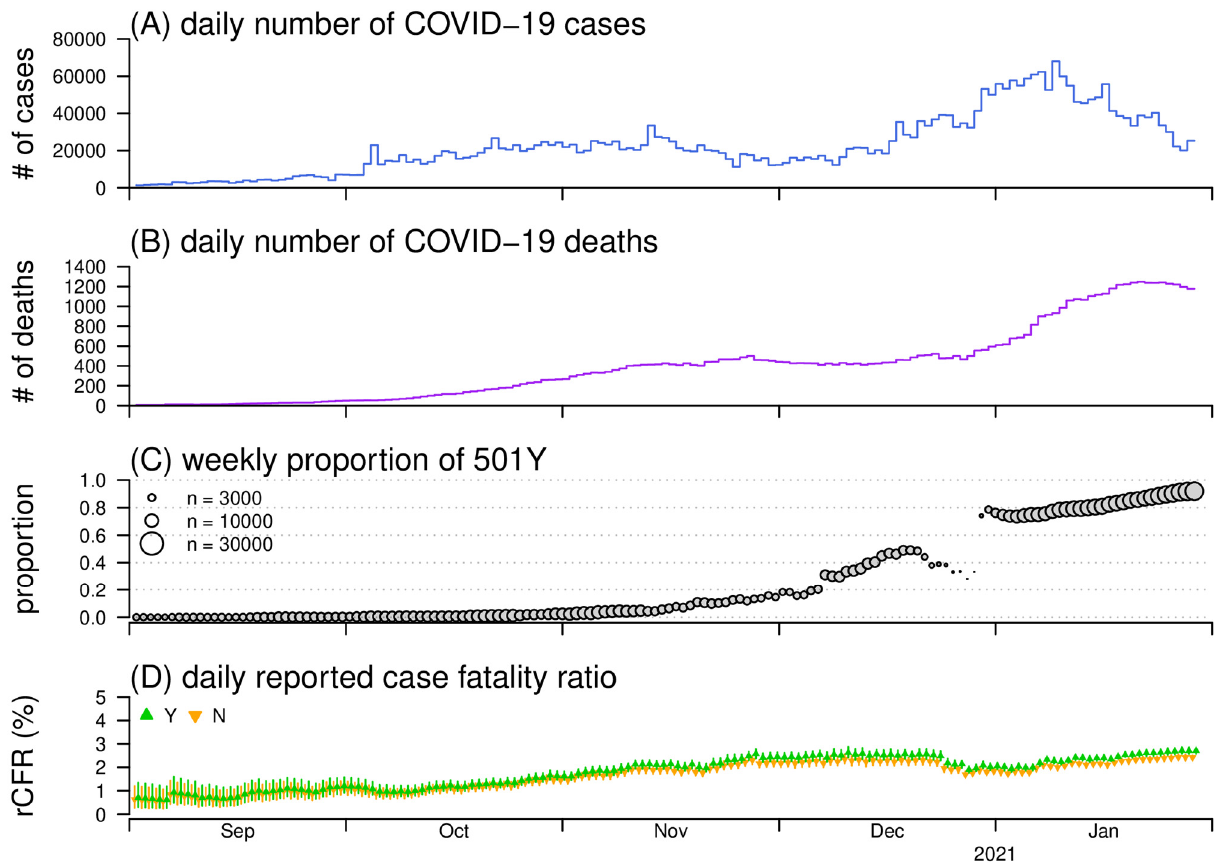
Figure 1. The daily number of COVID-19 cases ( A ) and deaths ( B ), proportion of the 501Y SARS-CoV-2 variants ( C ), and the reconstructed reported case fatality ratios (rCFR) ( D ). Panel ( A ) and ( B ) show the daily number of COVID-19 cases and deaths time series in the UK, respectively. Panel ( C ) shows the observed proportion of 501Y variants among all samples of SARS-CoV-2 strains, where the size of the dot indicates the weekly sample size. Panel ( D ) shows the estimated rCFR of 501N (in orange) and rCFR of 501Y (in green). where the dots are the point estimates and bars are the 95%CIs.